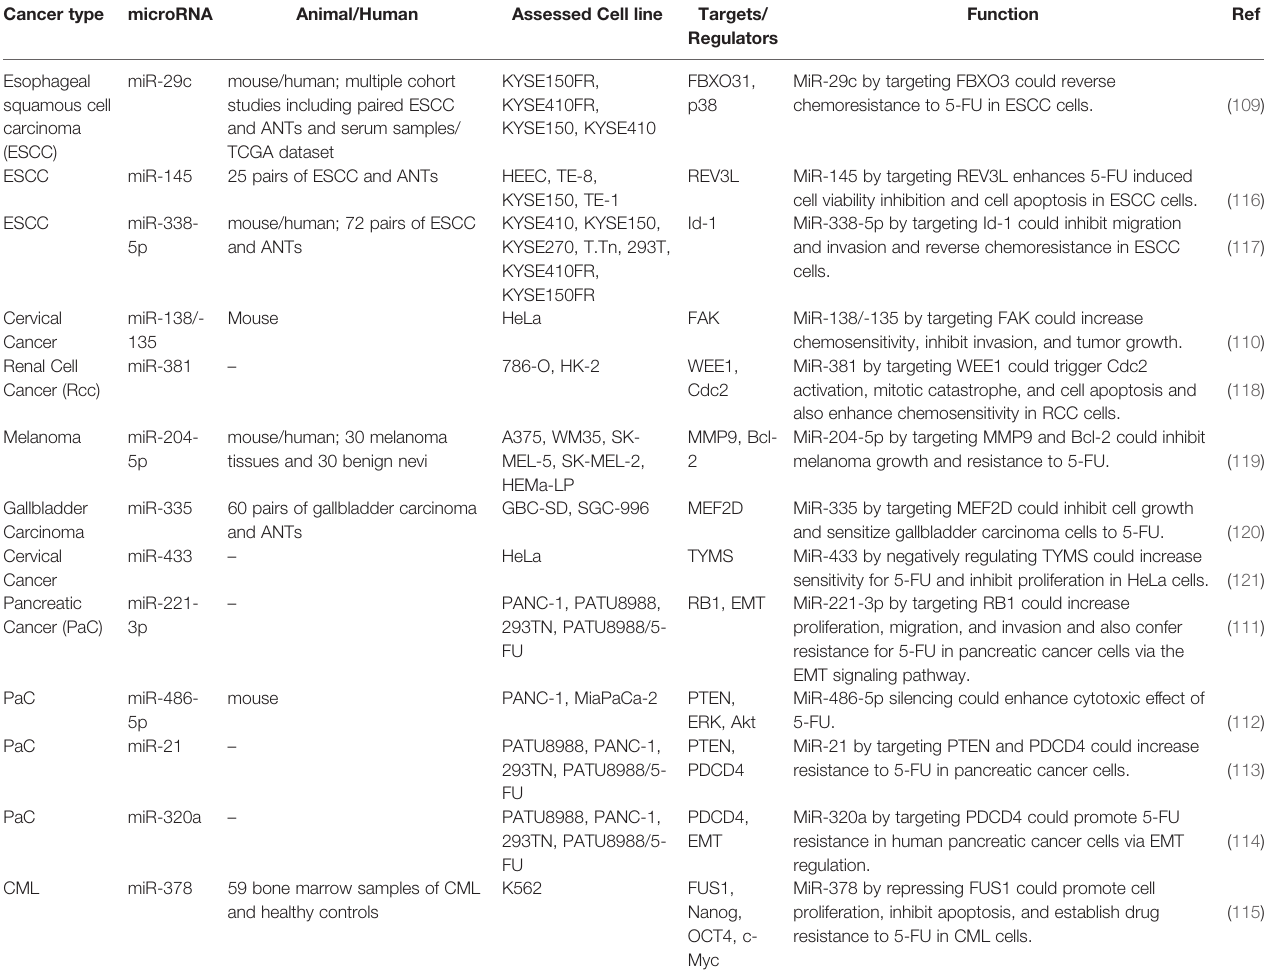
TABLE 4 | Impact of miRNAs in the modulation of response to 5-FU in other types of cancer (ANT, adjacent normal tissue). Cancer type